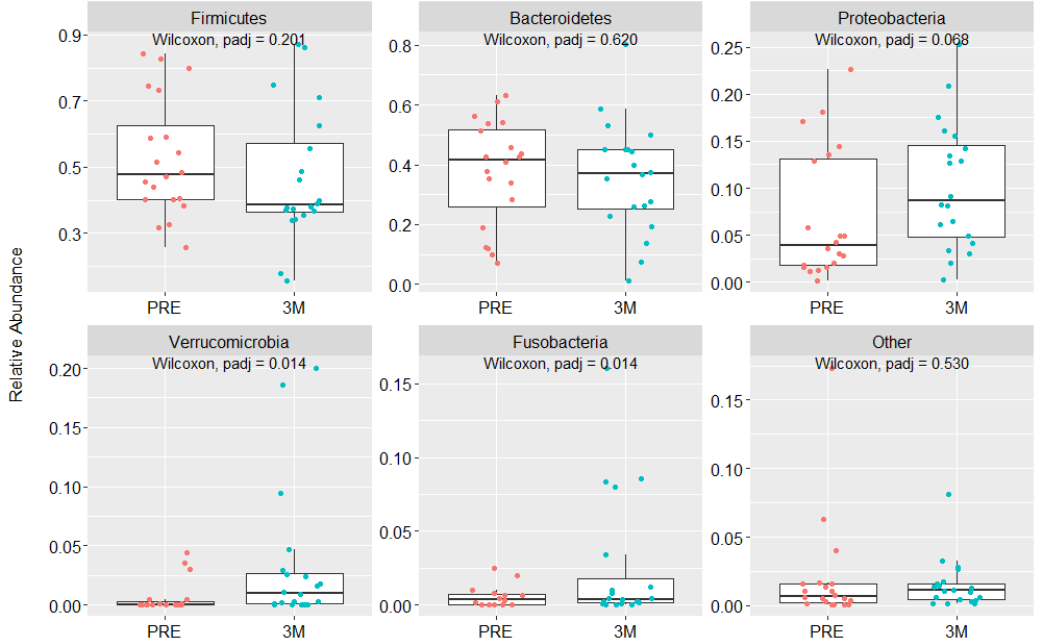
Figure 2. Relative abundance (%) of changes in gut bacteria phyla before and three months after RYGB. Statistical significance p <